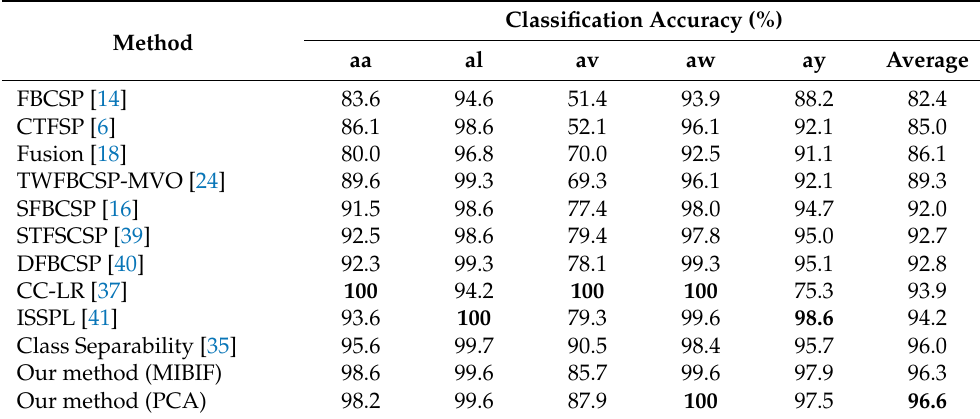
Table 6. Comparison of the classification performance between the proposed method and eight recently reported methods for Competition III dataset IVa (subject aa, al, av, aw, and